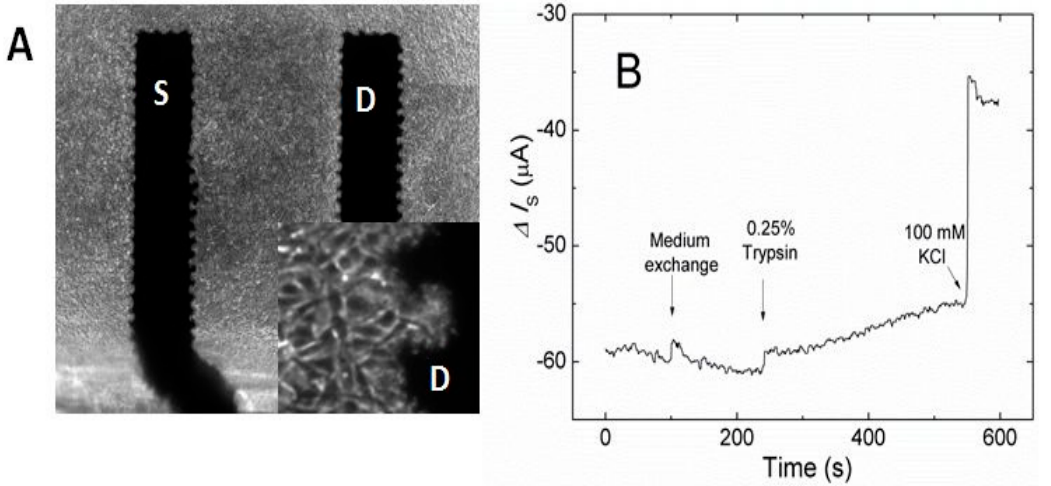
Figure 5. Electrochemical transistor with confluent layer of 3T3 fibroblasts: S—source, D—drain ( A ). The electrical response to cell release due to trypsin. 100 mM KCl spike served as a positive control of transistor function ( B ). Typical results out of three biological replicates are shown.